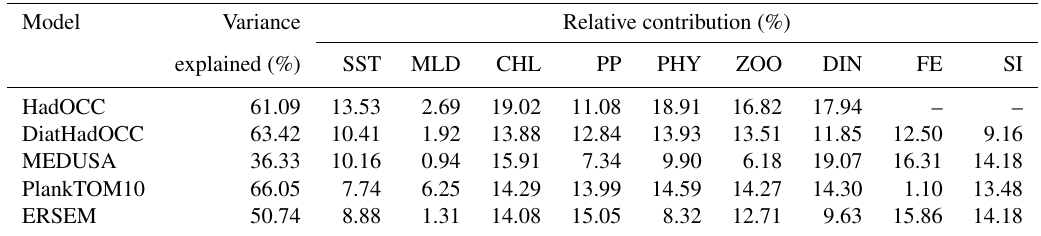
Table 4. Results of the principal component analysis: percentage of variance explained by the first principal component (PC1) and relative contributions of the different variables to this